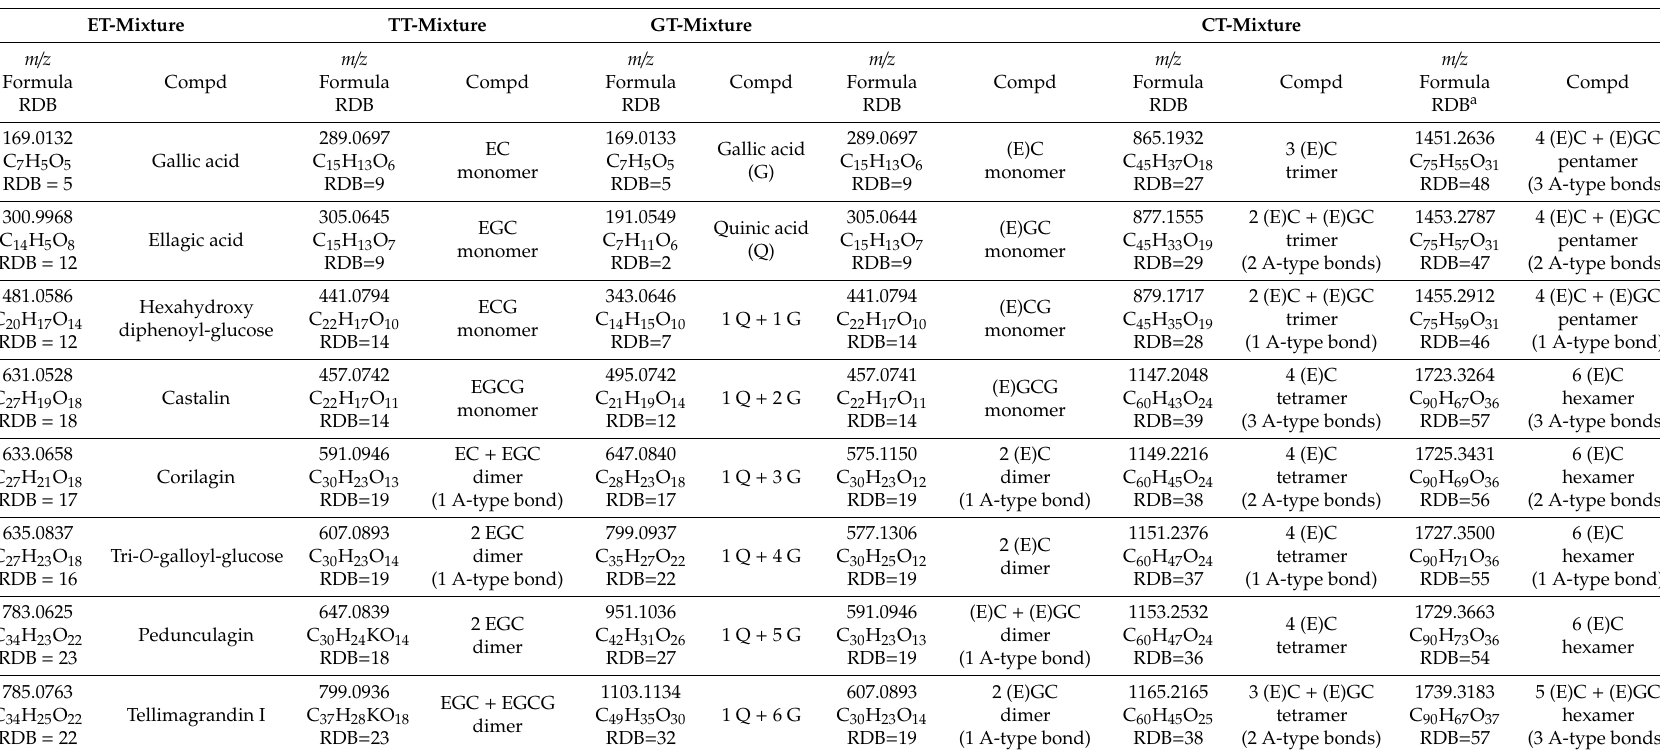
Table 1. Monomers and oligomers identified by HR ESI-MS (negative ion mode) in the ellagitannin (ET), tea tannin (TT), gallotannin (GT), and condensed tannin (CT) mixtures. Identification of compounds was proposed on the basis of the molecular formula implied by the ion peak values with a mass tolerance of 10 ppm; RDB is the degree of unsaturation represented as rings and / or double